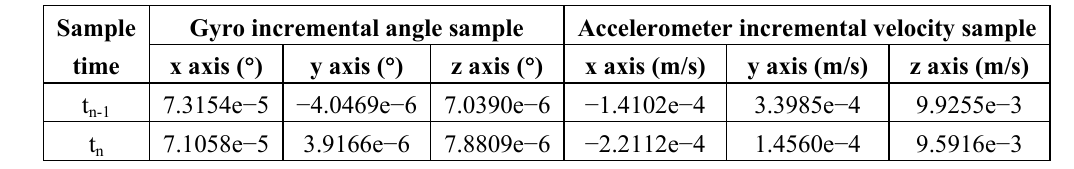
Table 1. ( a ) Simulation results—gyro and accelerometer inputs; ( b ) Simulation results— attitude, velocity and position